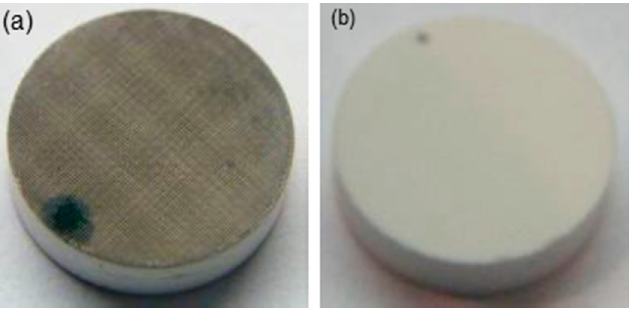
Figure 8. Laser-treated sample ( a ) before and ( b ) after post-treatment in an oven at 700 °C.